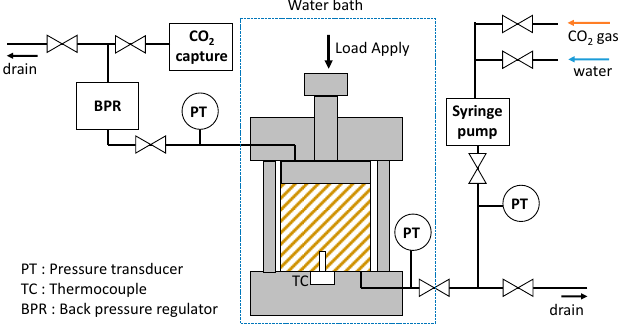
Figure 3. Experimental setup schematic.